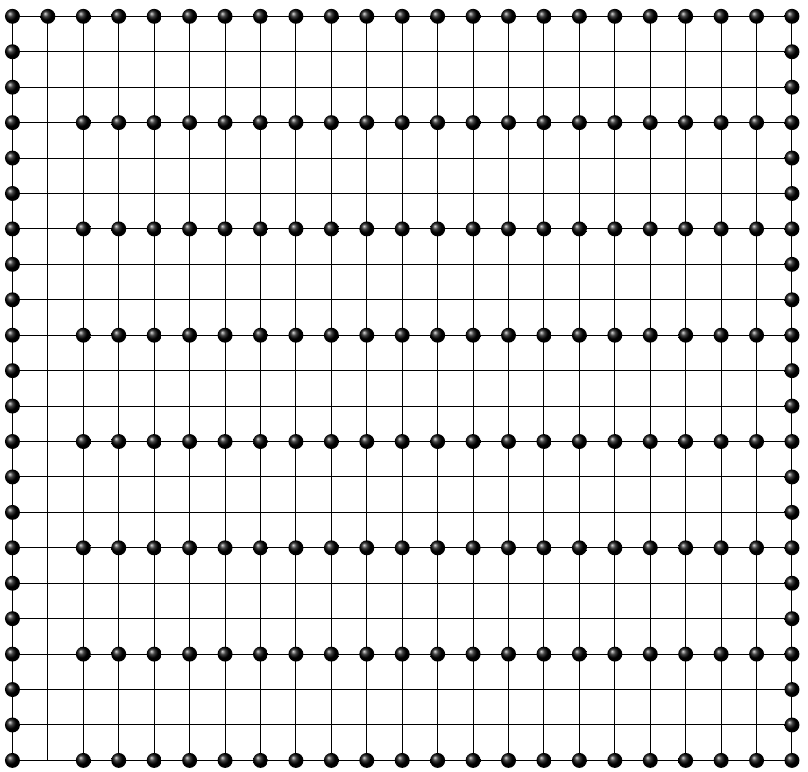
Figure 9. G [ 23,22 ] and its doubly connected dominating set. Nodes not belonging to the doubly connected dominating set are not marked and located at the intersections of the links without the black